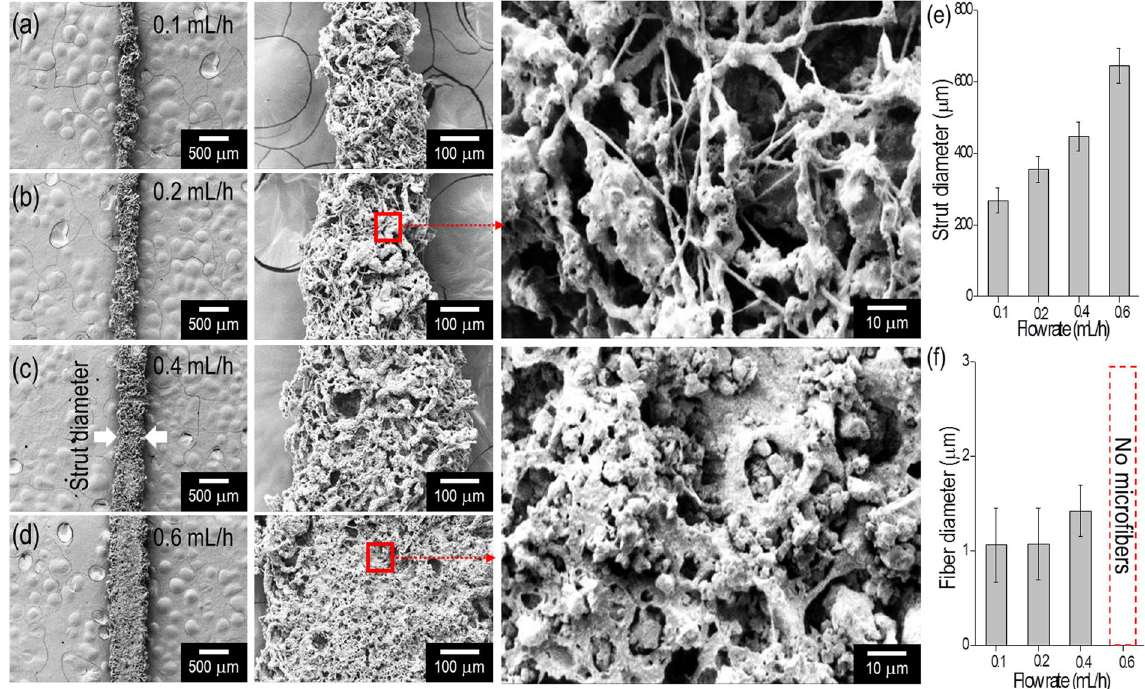
Figure 5. The effect of various flow rates (( a ) 0.1 mL/h, ( b ) 0.2 mL/h, ( c ) 0.4 mL/h, and ( d ) 0.6 mL/h) of the ceramic mixture on the formation of fibrous structure of the printed strut. ( e ) Diameter of fabricated struts and ( f ) diameter of the constituting microfibers for various flow